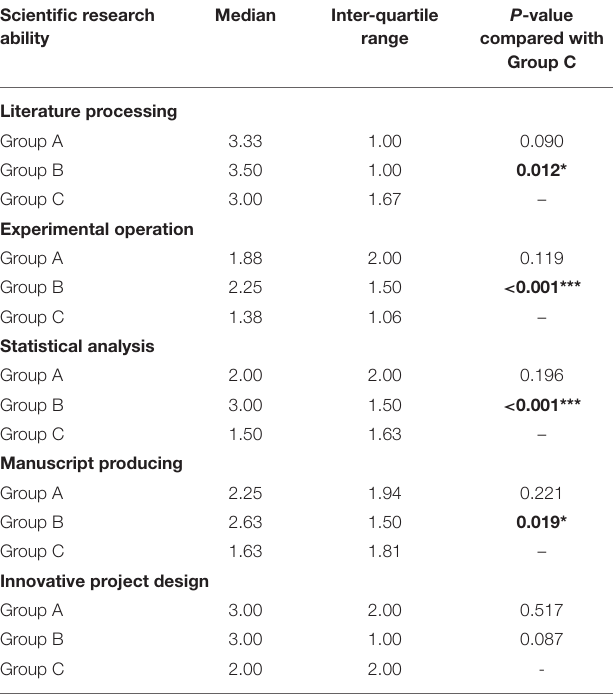
TABLE 6 | The assessment of students’ scientific research ability in literature processing, experimental operation, statistical analysis, manuscript producing, and innovative project design with the 5-point Likert